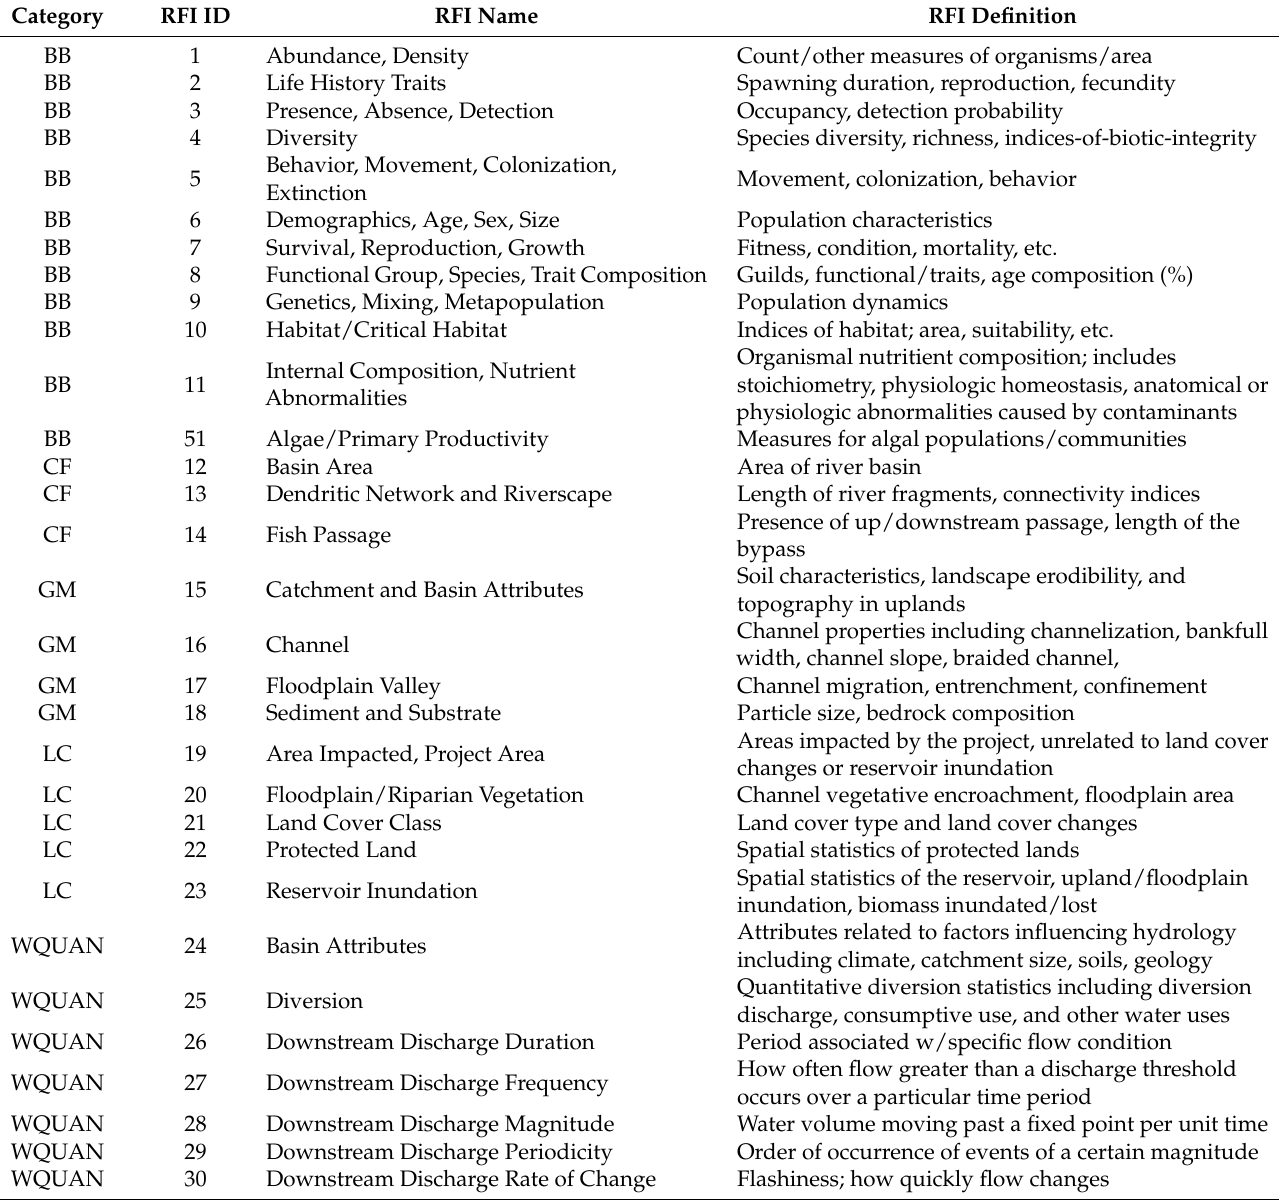
Table 1. Categories [7] and RFIs [5] assigned to studies documented in the two novel environmental life cycle datasets. Note that recreational and cultural RFIs were only recorded for the 23 projects documented through analysis of FERC study plan determination